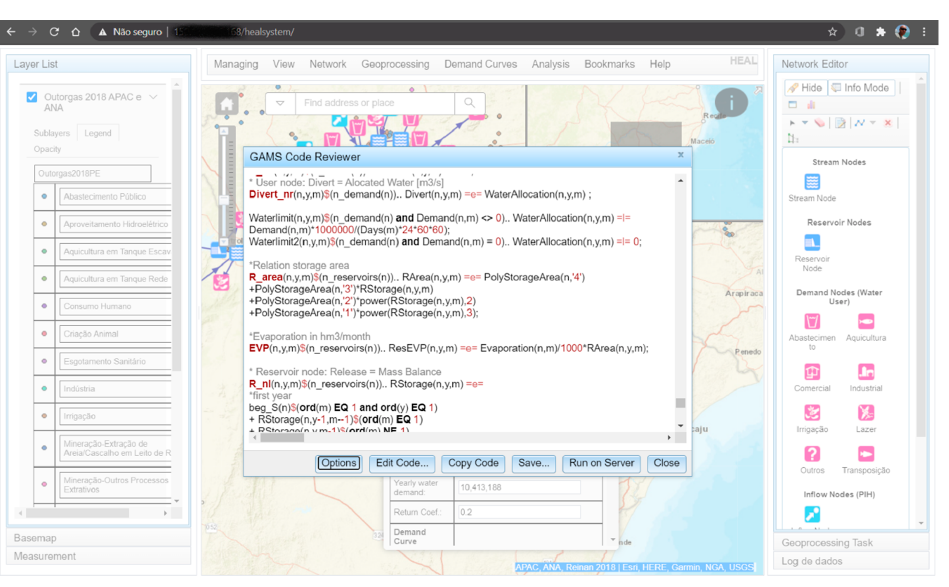
Figure 2. Mathematical programming model (GAMS) of the study area created using HEAL system.